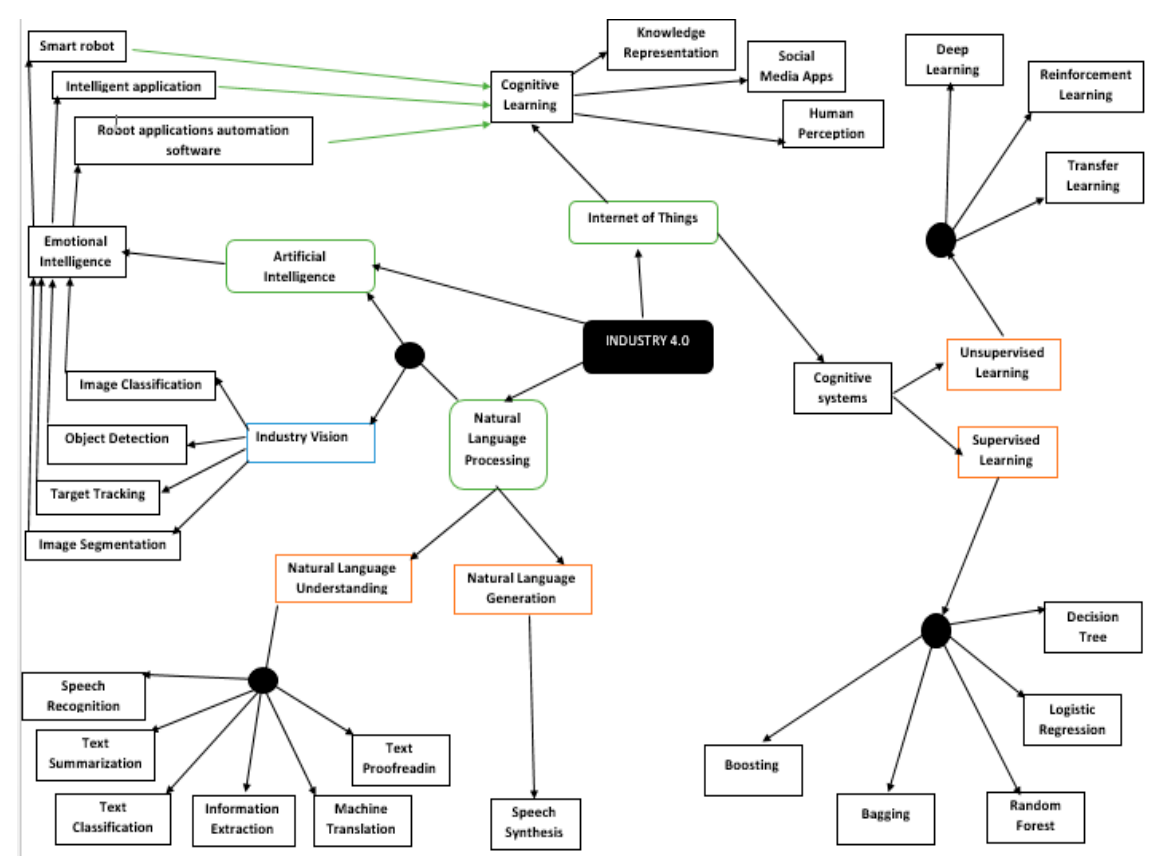
Figure 9. Vivid integration of NLP and AI with